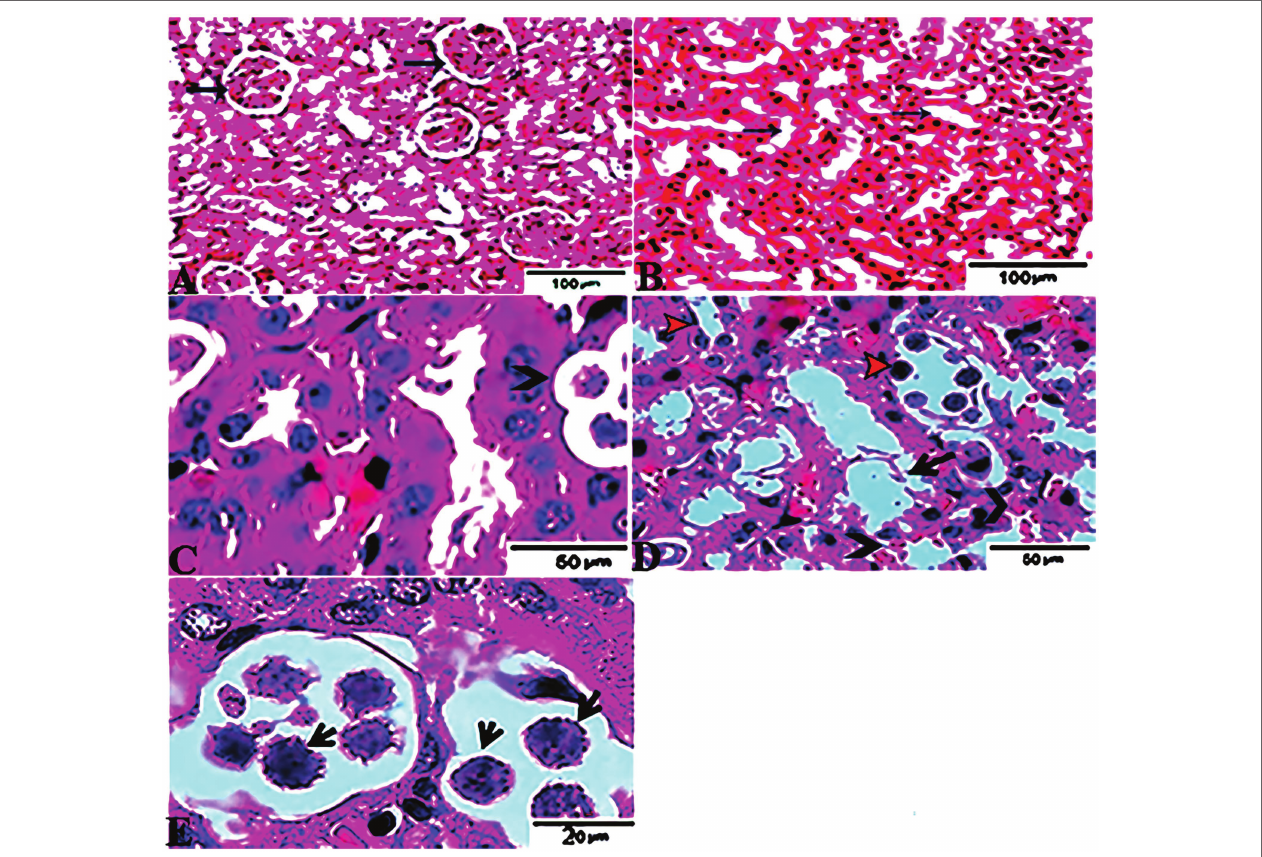
FIGURE 3 | Photomicrograph of kidney sections from experimental mice groups stained with Hx&E stain: (A,B) represent tissue sections from control group showing normal histological architectures compromising in normal glomerular structure in the cortical area ( A , arrows), surrounded with normal convoluted tubules. Normal tubular structures in renal medulla area ( B , arrows); (C) renal tissue section from control positive group infected by Toxoplasma gondii showing; the presence of multiple T. gondii tissue cysts in the lumen of proximal convoluted tubules (arrow) associated with complete necrosis in their lining epithelium. (D) Kidney sections from the treated group for 14 days showing: the presence of marked infested multiple T. gondii tissue cysts in the lumen of proximal convoluted tubules (red arrowheads), severe necrosis in the lining epithelium of proximal convoluted tubules (arrows) associated with moderate extravasation of blood among renal tubules (arrowheads). (E) Renal tissue section from the treated group for 28 days showing: severe infested multiple T. gondii tissue cysts of ME49 Avirulent strain in the lumen of proximal convoluted tubules (arrows) associated with complete necrosis in their lining epithelium. The bar size of each picture was indicated under each